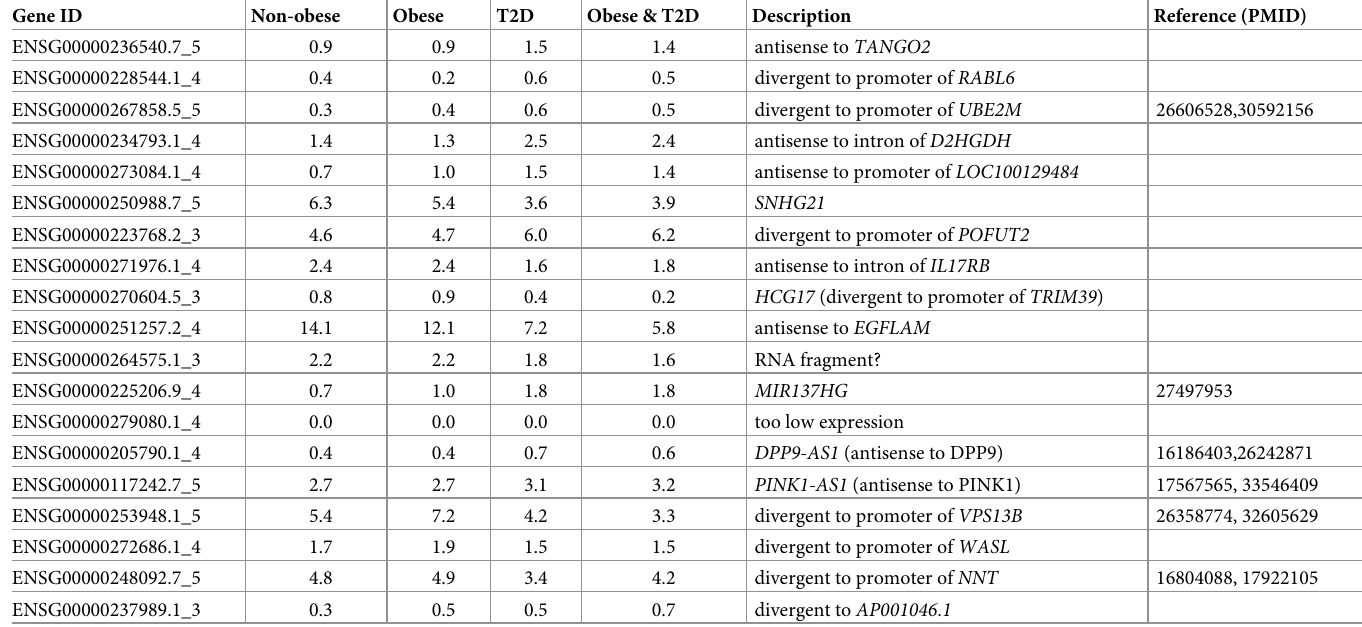
Table 1. Expression levels for each of the significantly altered lncRNAs from the skeletal muscle tissues of patients with diabetes.